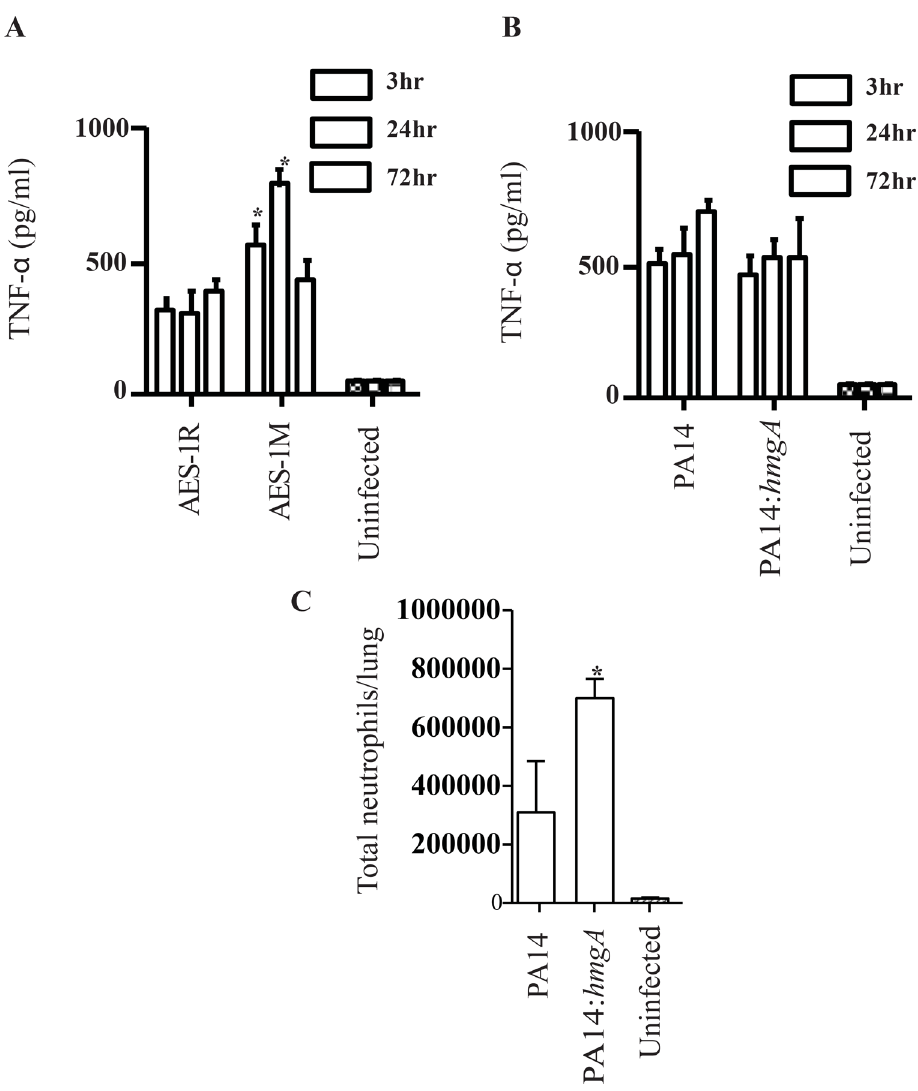
Fig 3. Mouse TNF- α response to lung infection with AES-1R, AES-1M, PA14 and PA14 Δ hmgA , and neutrophil populations in PA14 and PA14 Δ hmgA -infected mice. The TNF- α profile of P . aeruginosa - infected mice was determined in lung homogenates at 3-, 24- and 72-hrs post-infection by ELISA. A. AES-1M elicited a rapid and significantly greater TNF- α response compared to AES-1R at 3 and 24-hr, and both responses were still at > 400pg/ml at 72hr despite the absence of bacteria in lungs. B. Both PA14 and PA14 hmgA elicited a rapid TNF- α response compared to control uninfected mice by three hrs post-infection however there was no significant difference between them. The significances of differences between strains were determined by ANOVA * p < 0.0001 vs. AES-1R. C. Mice were infected with 10 6 CFU of either wildtype PA14 or PA14 Δ hmgA and lungs were harvested at 72-hrs post-infection. Single cells suspensions were stained and analysed by FACS. Neutrophil populations were identified based on their CD11b + Ly6G + phenotype. Total cell numbers in the lung were determined based on the number of stained cells. Infection with PA14 Δ hmgA was marked by a significant increase in the number of neutrophils in the lung compared to mice infected with PA14. The significances of differences between strains were determined by ANOVA * p < 0.05 vs. PA14